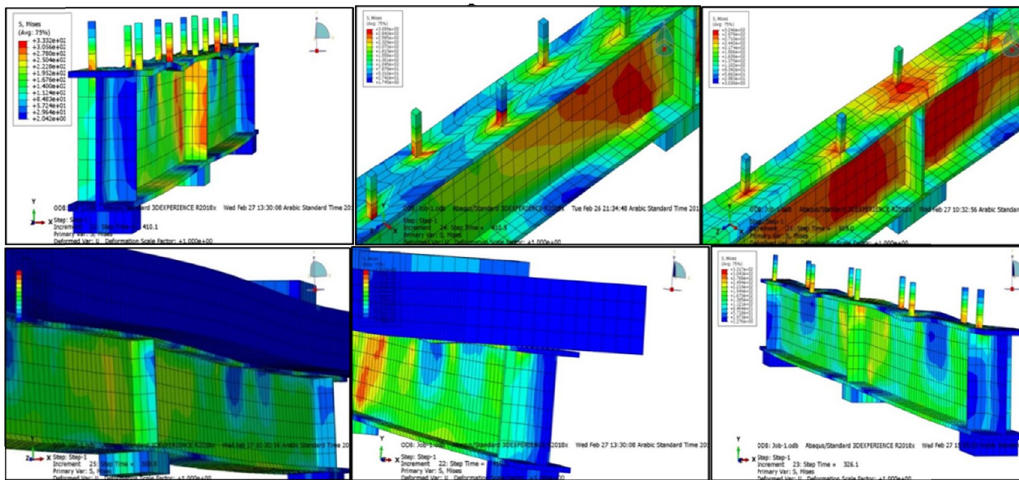
Figure 16: Stress distribution for Group D.